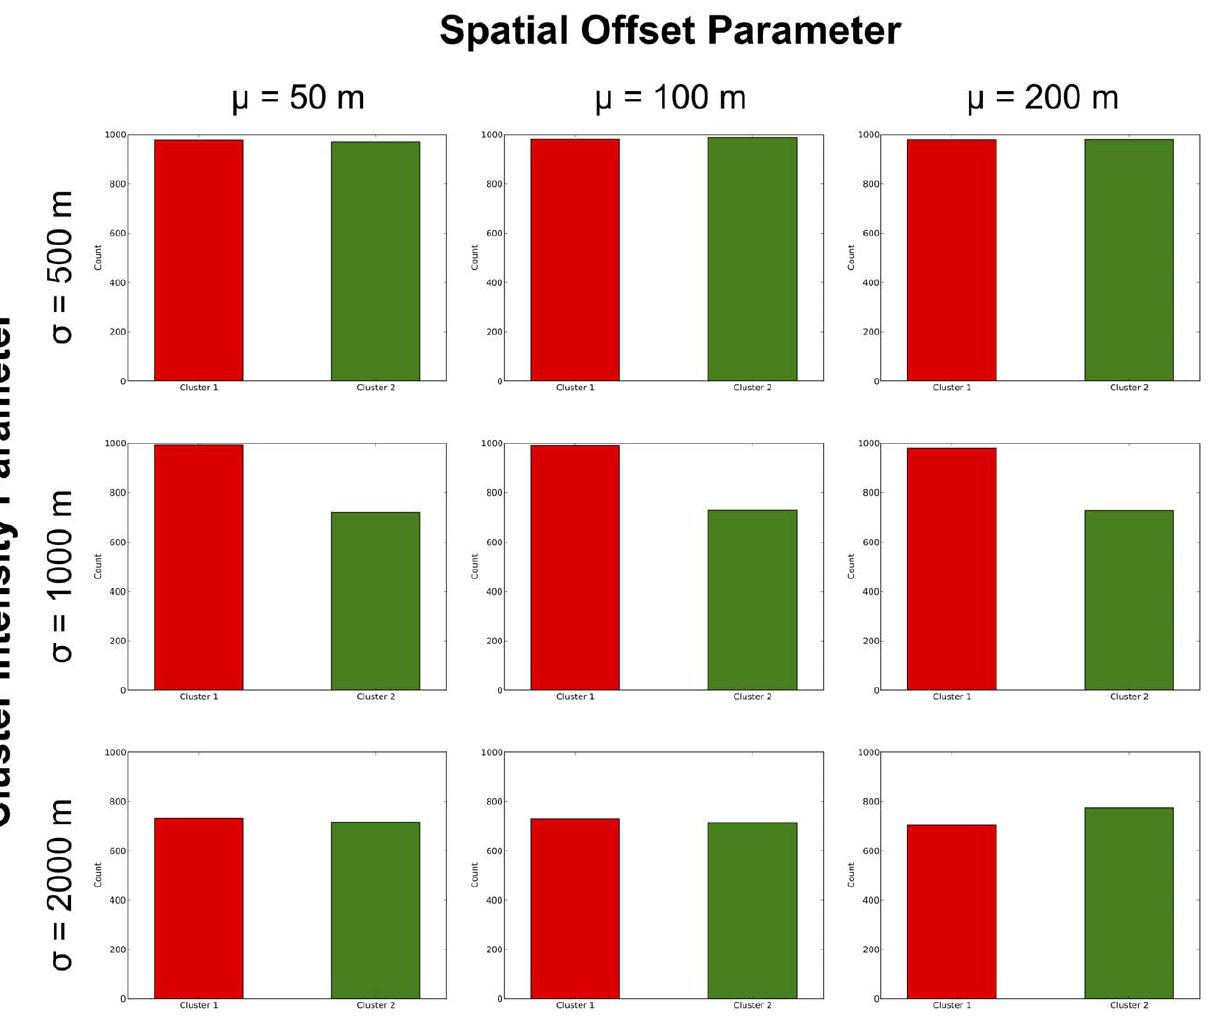
Figure 8. Number of perturbed patterns where Clusters 1 ( in red ) and 2 ( in green ) were identified as ‘‘likely clusters’’ by the STPSS.